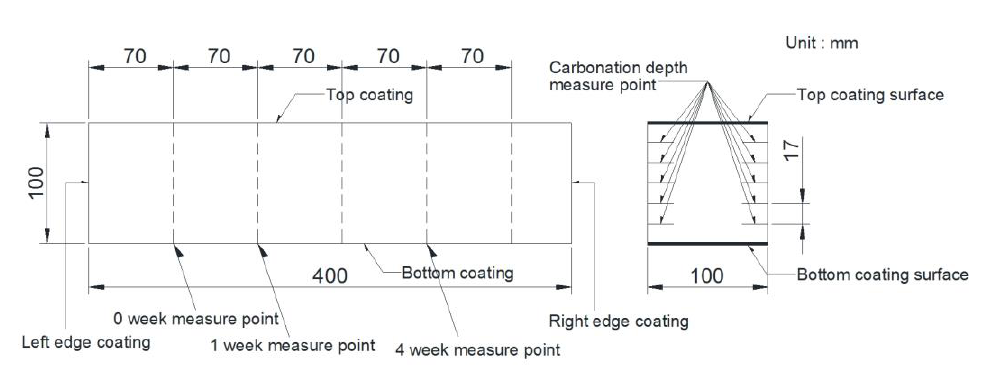
Figure 1. Carbonation test specimens and measurement points.